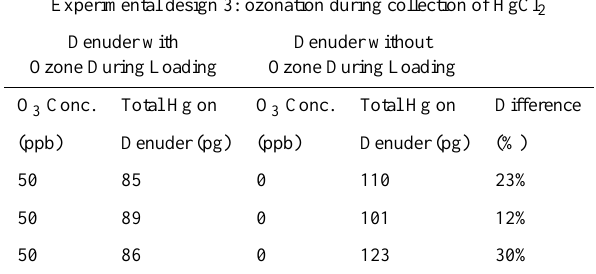
Table 3. Mercury collected by KCl denuders loaded with HgCl 2 in the presence of 50ppb ozone or no